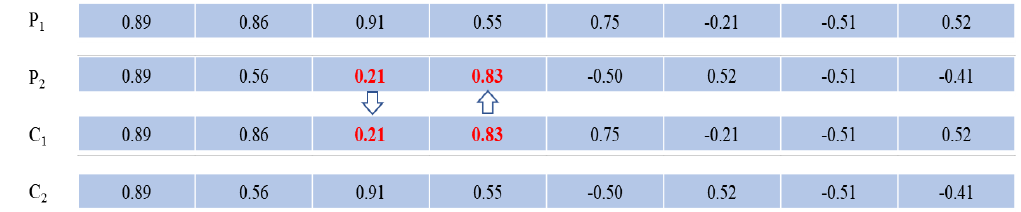
Figure 5. Recombination, two-point crossover. P1 and P2 were chosen randomly from within the genes in the parents. C1 and C2 are the generated children.